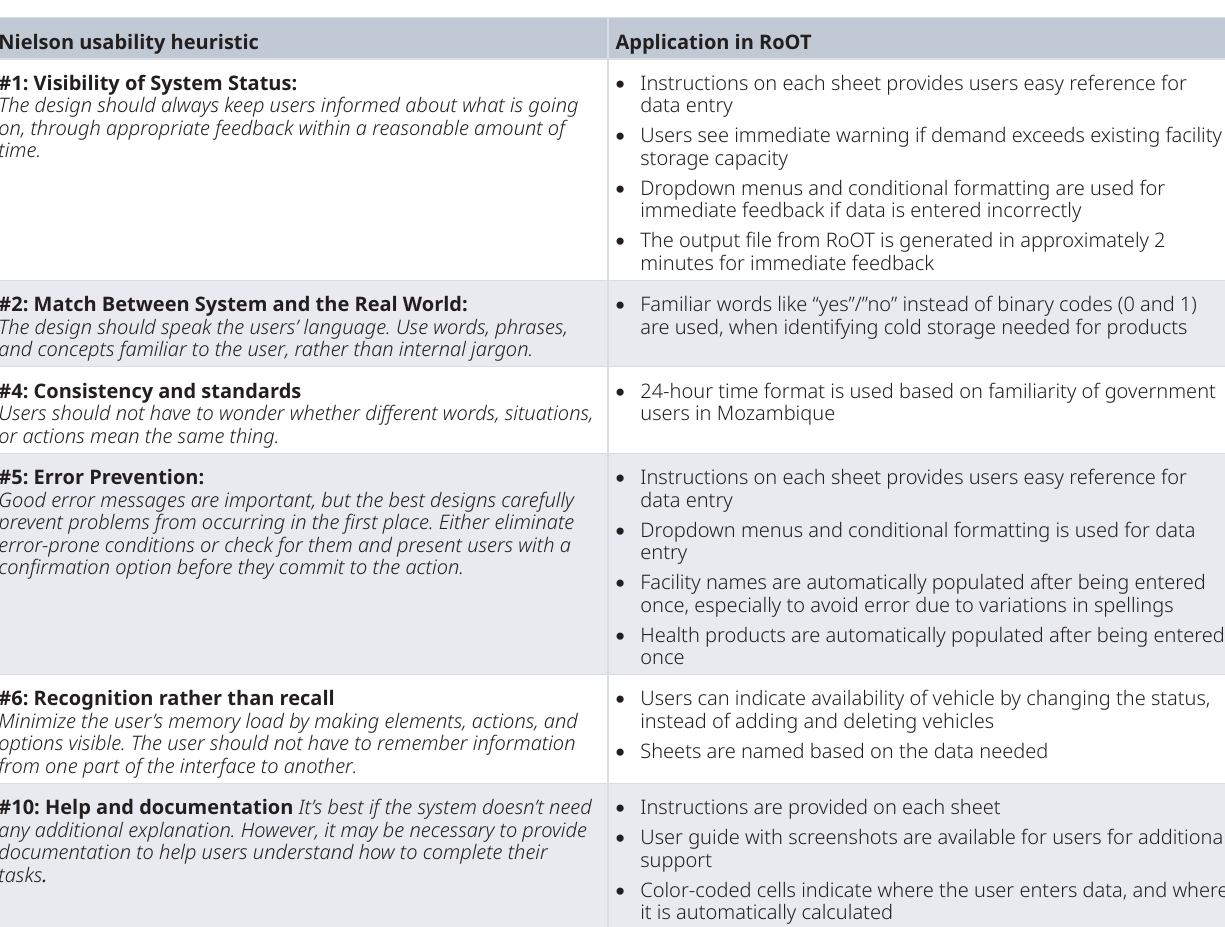
Table 1. Nielson’s usability heuristics applied in